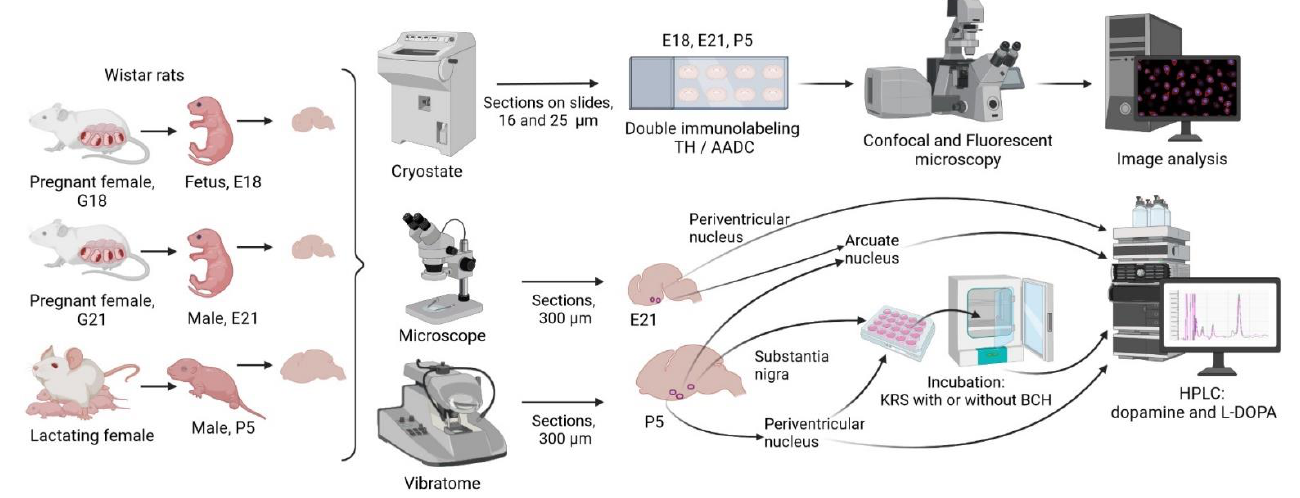
Figure 11. The design of experiments on Wistar rats on embryonic day 18 (E18), E21, and on postnatal day 5 (P5). AADC, aromatic l-amino acid decarboxylase; BCH, 2-aminobicyclo[2.2.1]heptane-2-carboxylic acid; L-DOPA, L-3,4-dihydroxyphenylalanine; HPLC, high-performance liquid chromatography; KRS, Krebs-Ringer solution; TH, tyrosine hydroxylase.